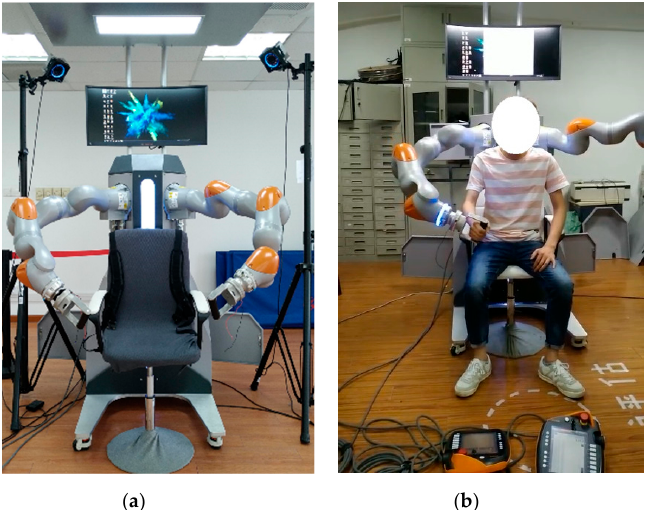
Figure 8. The EULRR prototype and subject testing. ( a ) the EULRR prototype; ( b ) the testing of the subject.